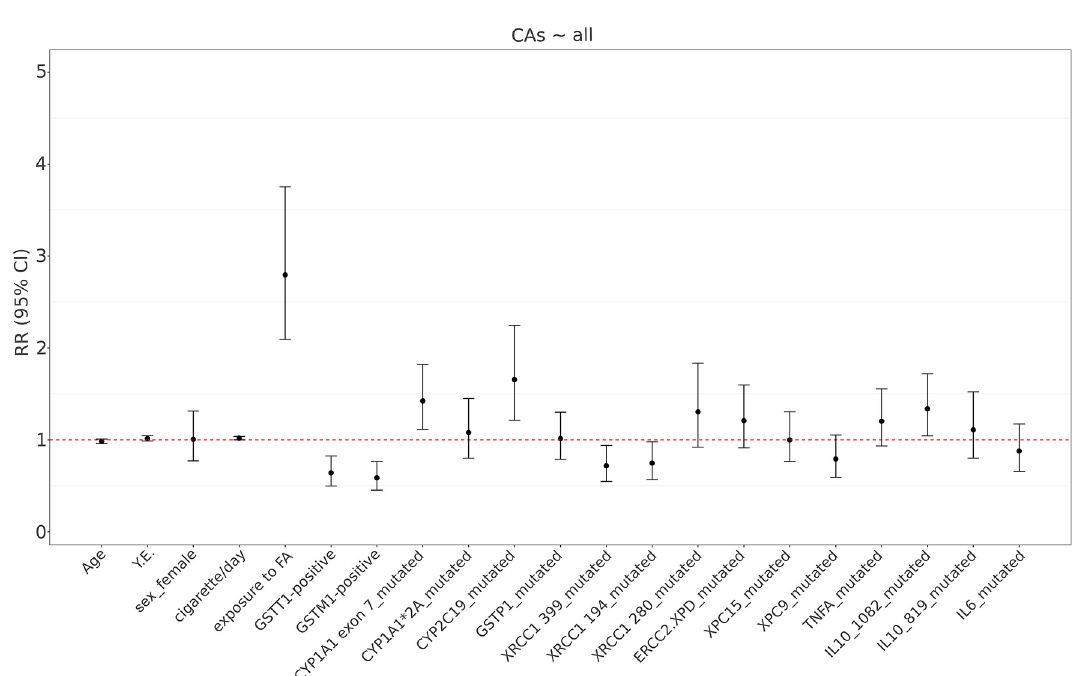
Figure 2. RR (95% CI) of developing CAs according to the various mutated allelic variants of genes considered in the present study, FA exposure and confounding factors as age, years of exposure, sex and cigarette/day (Model